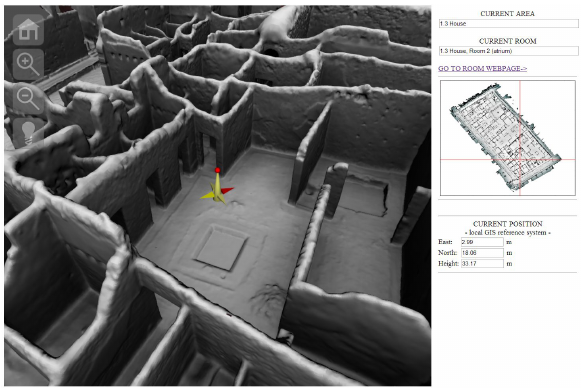
Figure 2: The visualization webpage interface. On left: the 3D view, in bird’s eye view mode, with the current point of interest shown by the 3D locator. On top right: the current area and room name, tracked using the location channel of the map. On middle right: the minimap, graphically showing the current position. On bottom right: the current position of the user, expressed in this specific case as relative coordinates with respect to a local origin defined in a GIS